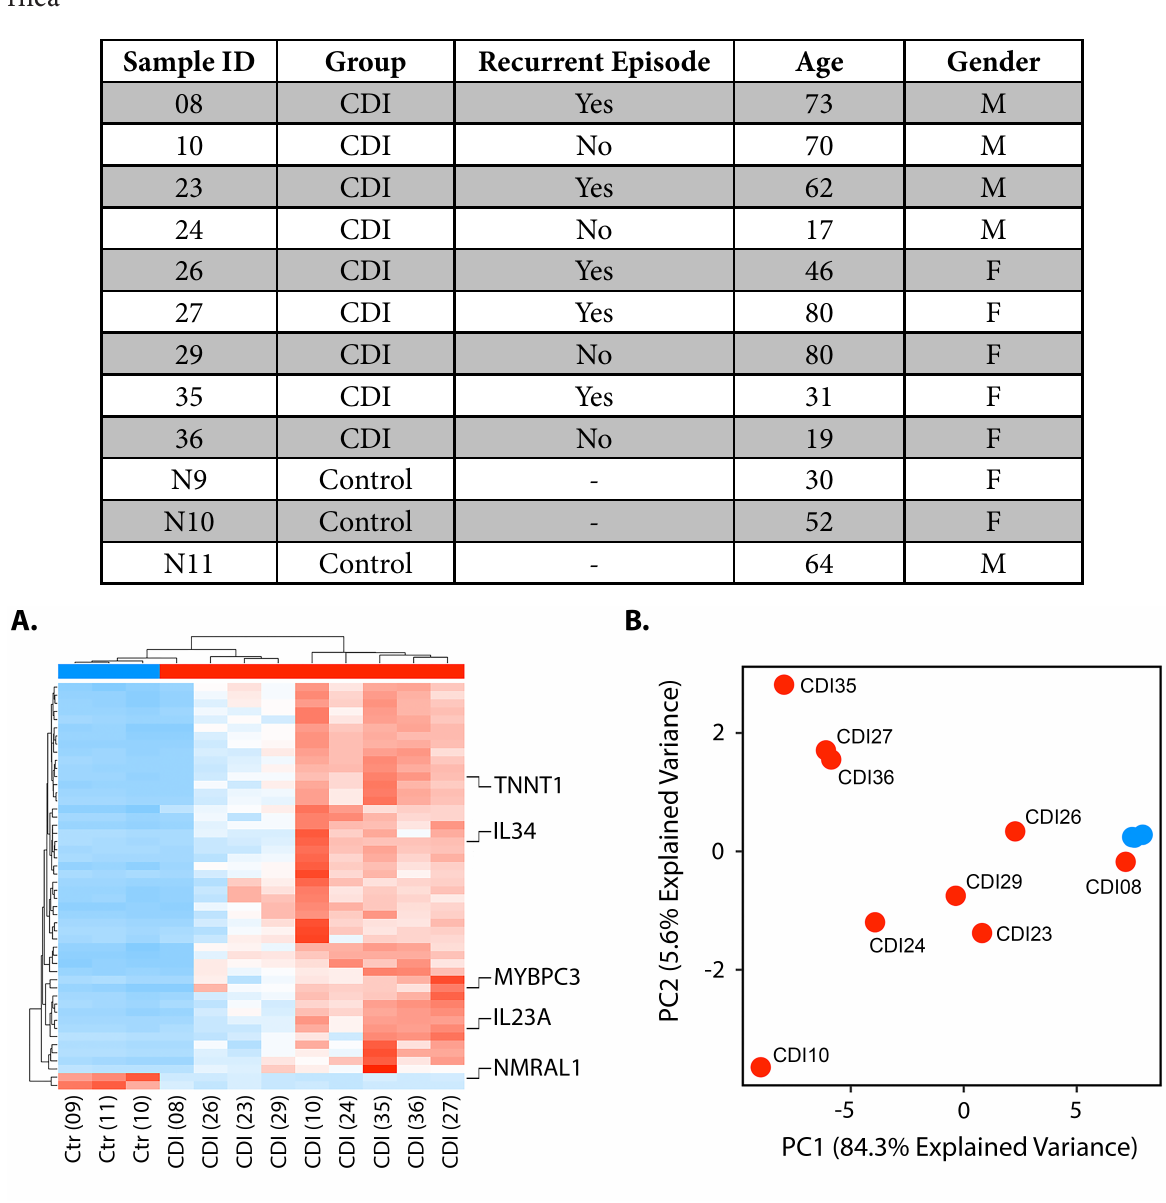
Table 1 . Demographic and clinical data for patients with CDI and controls with non-CDI diar-